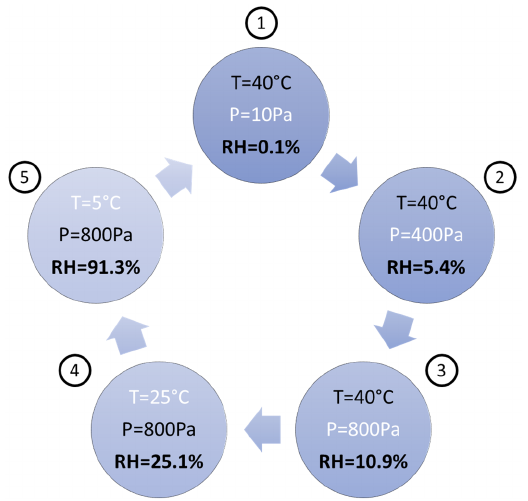
Figure 1. Schematic representation of environmental scanning electron microscopy (ESEM) analysis cycle conditions.